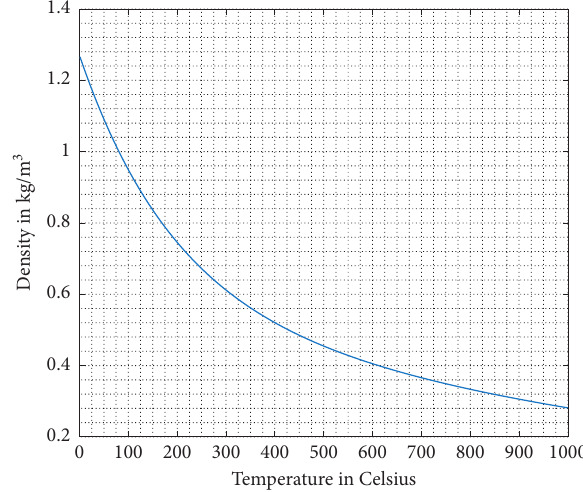
Figure 2: Density of air v/s temperature.